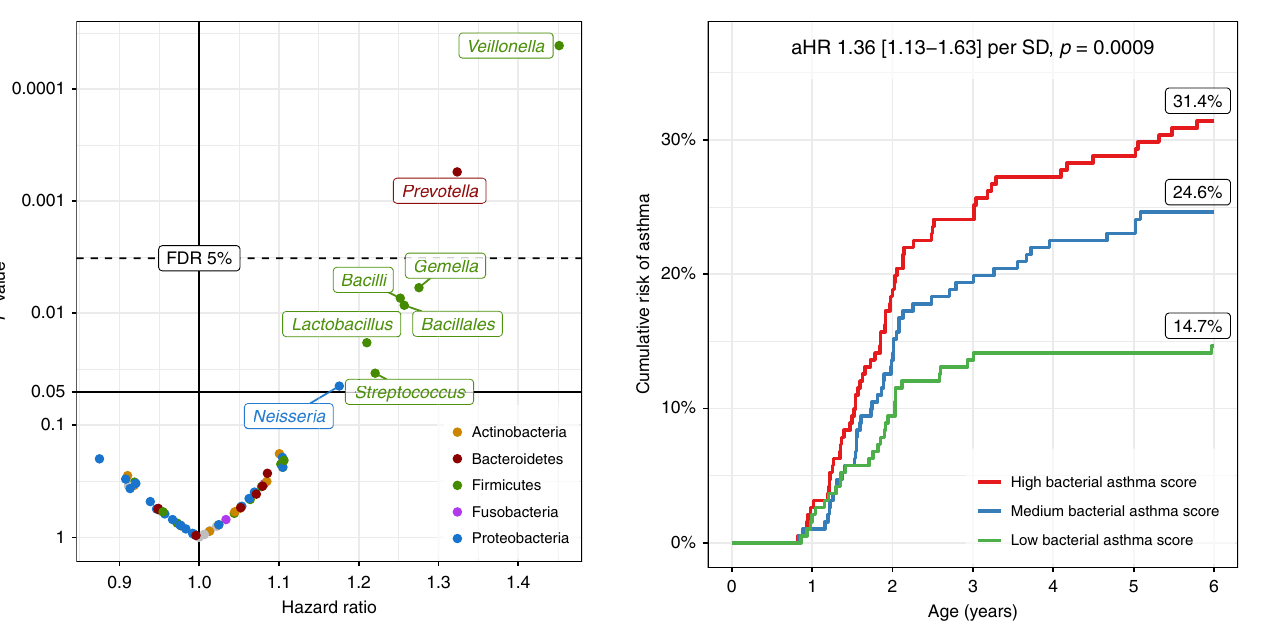
Fig. 2 Bacterial asthma score and asthma. Sparse partial least-squares (sPLS) model between genus-level relative abundances at 1 month of age and asthma by age 6 years. Kaplan – Meier curve showing cumulative risk of asthma by bacterial asthma score, divided into tertiles. n = 573 (191 in each tertile group). Adjusted hazard ratio (aHR) and 95% con fi dence interval corresponds to each standard deviation (SD) of the continuous score from the sPLS model, adjusted for paternal asthma, season of birth, and siblings in a Cox regression ( n = 554). The displayed percentages are the Kaplan – Meier estimates of asthma risk at 6 years in each tertile